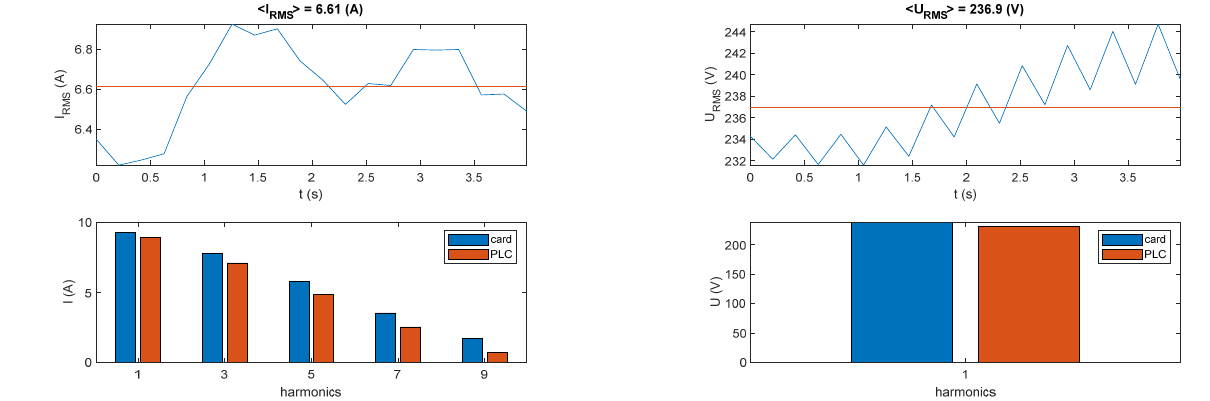
Figure 11. RMS and harmonics of current ( left ) and voltage ( right ) measured both with DAQ card and PLC. Alternatively, we can use two samples of voltage distanced by four samples (every fourth sample) (Figure 12).